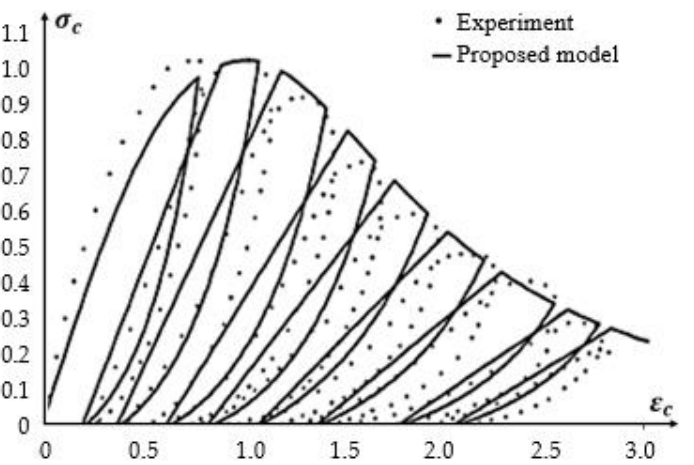
Figure 1. Relation σ − ε for a compressed element according to experimental results and a theoretical Figure 1. Relation − for a compressed element according to experimental results and a theoretical model. Adapted from Ref. model. Adapted from Ref. [1].